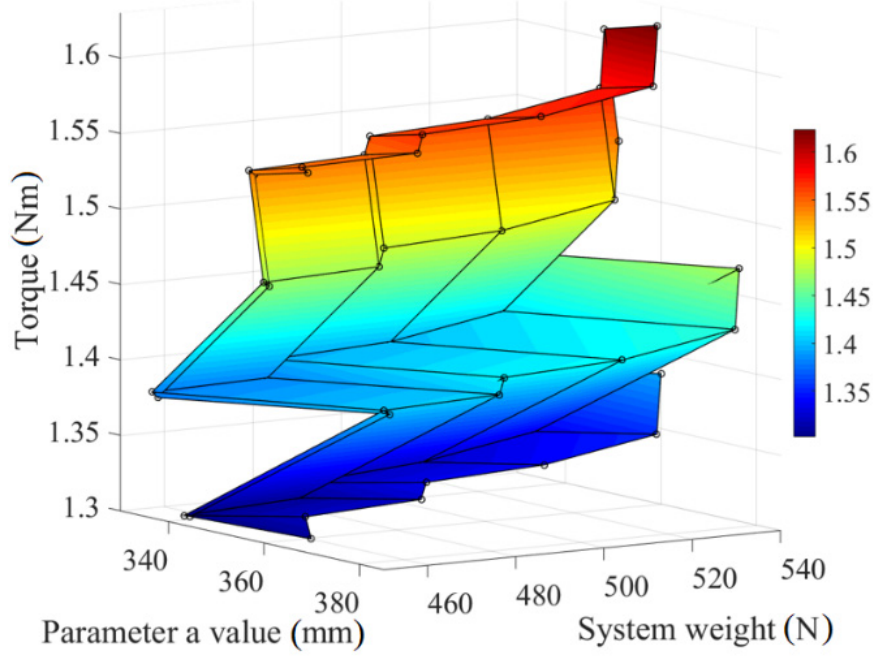
Figure 10. Demand for driving torque as a function of parameter 𝑎 value and system weight.